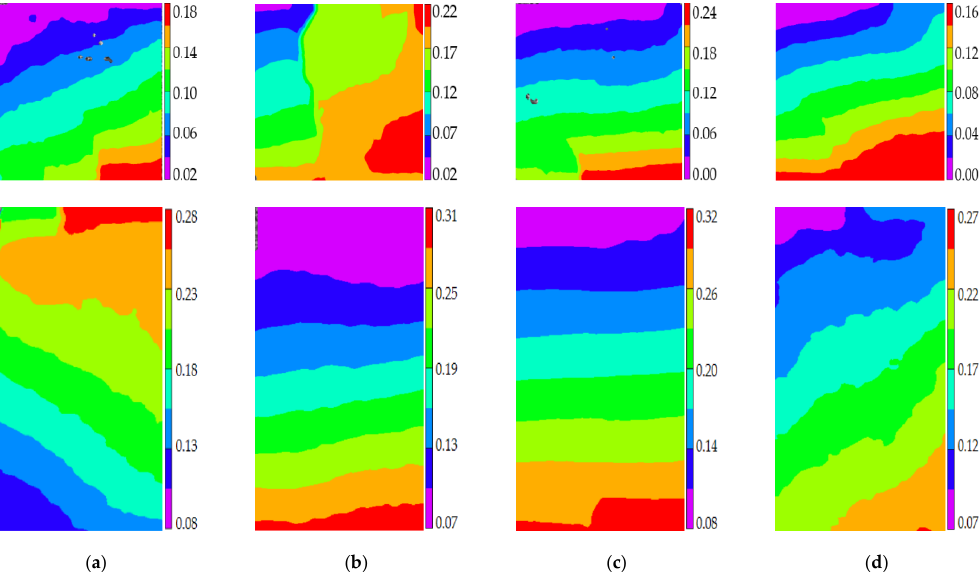
Figure 11. The horizontal strain cloud diagram of concrete with different coarse aggregate volume fraction at the turning point of damage stage I, ( a ) 0 %, ( b ) 20 %, ( c ) 40 %, ( d ) 60 %.